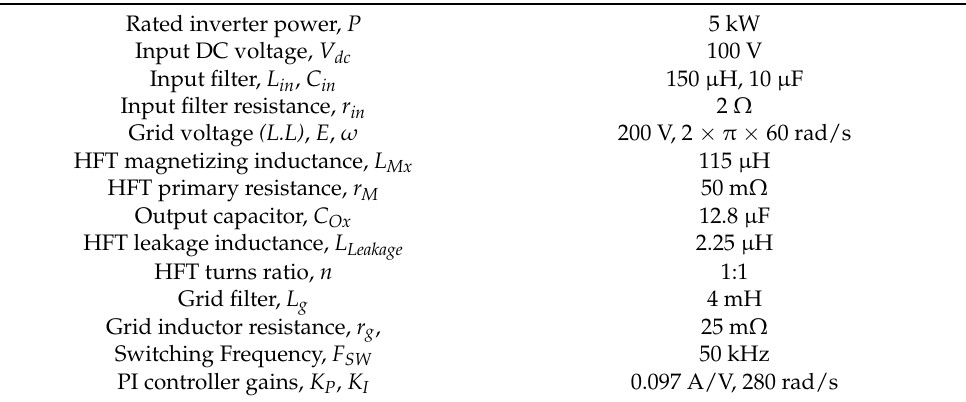
Table 5. Simulation parameters of the